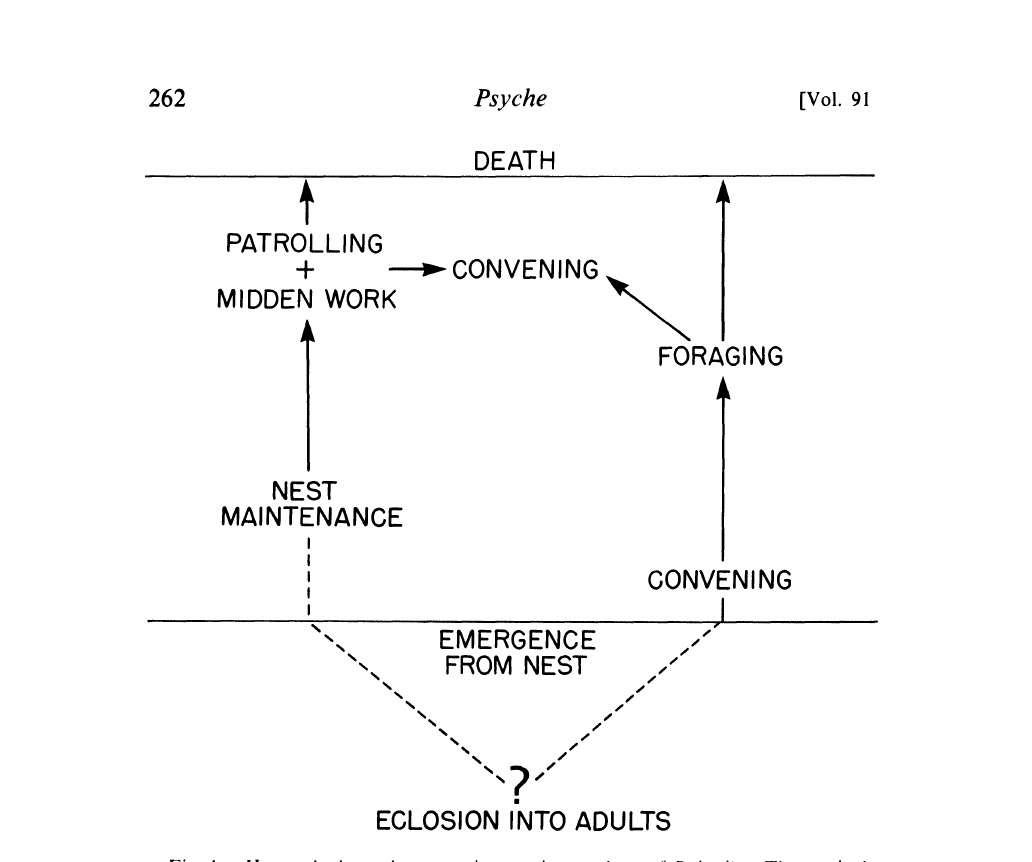
Fig. i. How role depends on age in exterior workers ot" P. hadius. The vertical direction represents worker